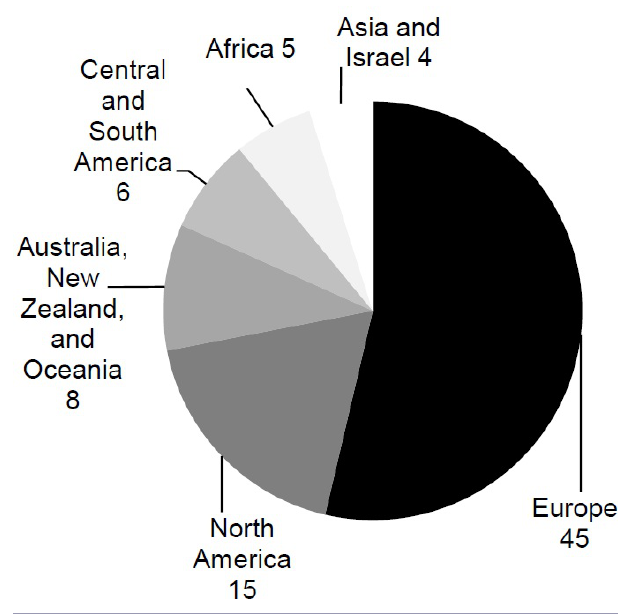
Fig. 2 . Regional distribution of case studies in the review. Publications could have no entries or multiple entries if, respectively, they contained no or multiple case